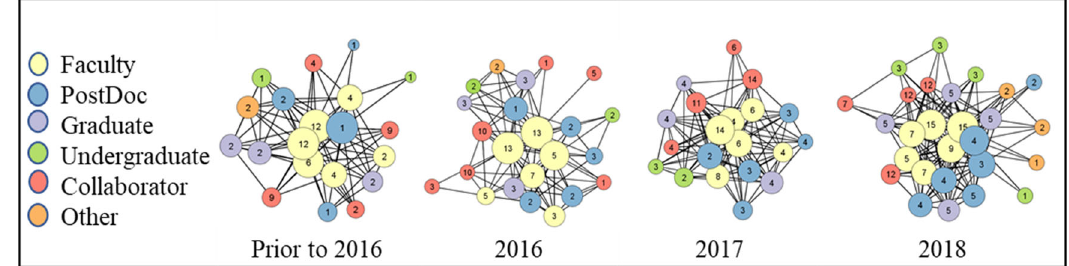
Fig. 5 Over time, junior scientists migrated to be core members of the scienti fi c productivity network. Social network measures of productivity (research/consulting, grants, publications, and serving on student committees) were recorded over time. Each node represents a person on the team, and nodes are sized by average degree (see text). Colours denote different roles on the team. The node label indicates the number of years a person has been part of the team.